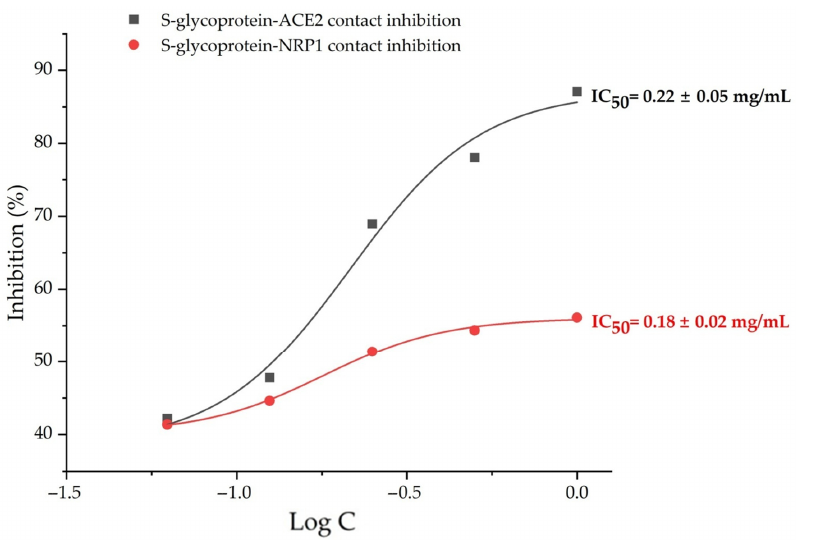
Figure 6. Concentration-inhibition curves of A. viridiflora methanol extract on S-glycoprotein-ACE2 (black line) and S-glycoprotein-NRP1(red line) contacts.